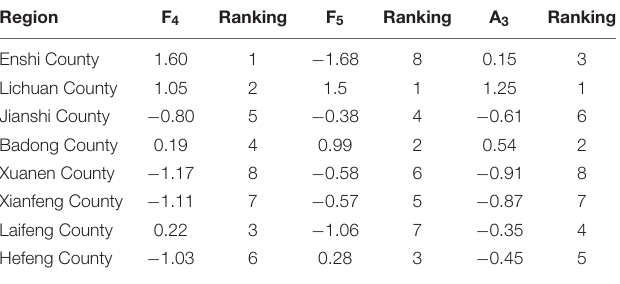
TABLE 17 | Scores and rankings of EAP’s mountain tourism